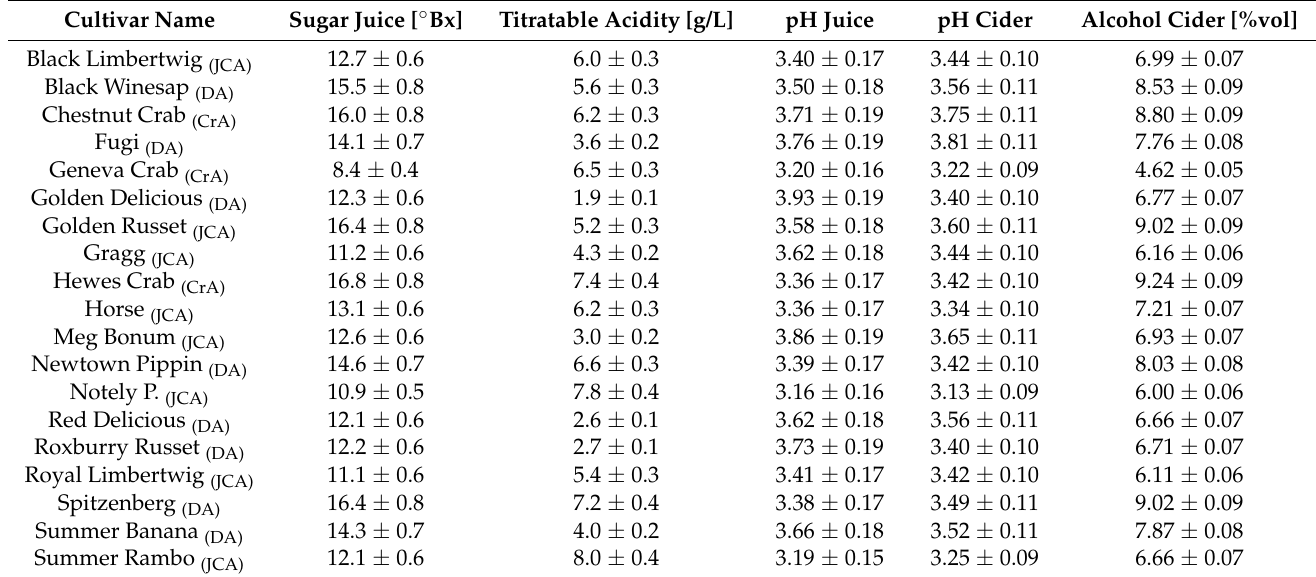
Table 1. Apple cultivars included in this study, in alphabetic order with all relevant juice and cider data (JCA: Juice/cider apple; DA: Dessert apple; CrA: Crab